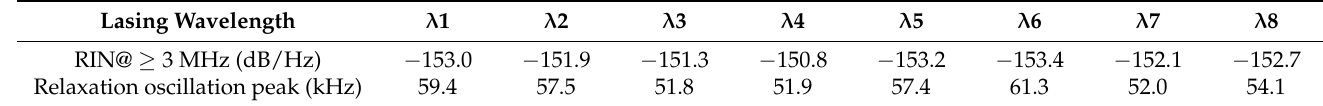
Figure 8. RIN spectra of the single-wavelength lasing operations at ( a ) λ 2 and ( b ) λ 7 in the range of 0–5 MHz, with an RBW of 10 kHz. The insets show the RIN spectra measured in the range of 0–500 kHz, with an RBW of 100 Hz, as well as the positions of the relaxation oscillation peaks of the lasers. Table 3. RIN measurement results of the single-wavelength lasing